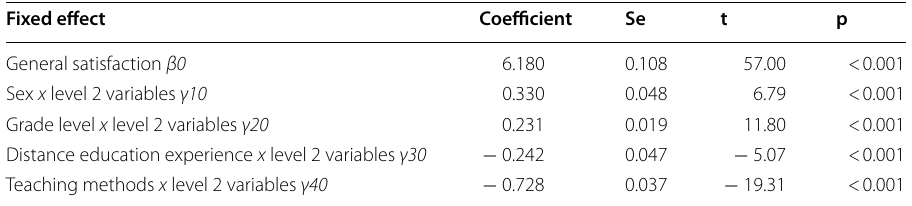
Table 6 Intersection and slope model regression model